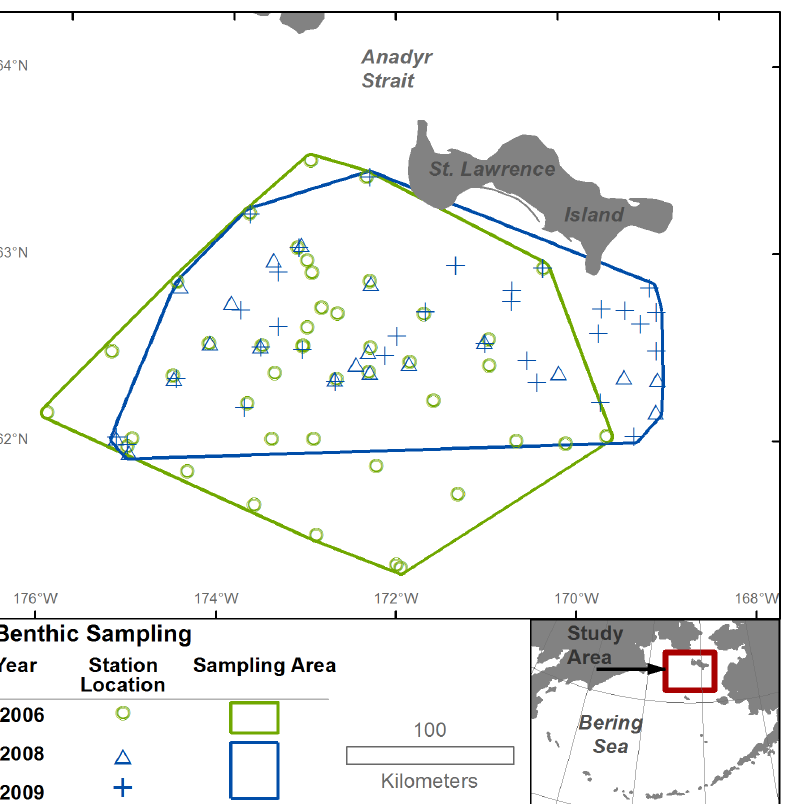
Figure 1. Location of benthic sampling stations. Stations were sampled with a 0.1 m 2 van Veen grab in March–June 2006, 2008, and 2009. Stations from 2008 and 2009 were combined in our analysis to represent the distribution of macroinfauna for these years. Sampling areas from the benthic sampling periods (2006 and 2008–2009) were delineated using a minimum convex polygon.